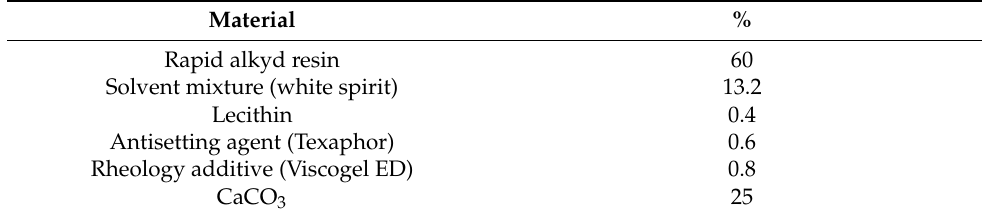
Table 1. Formulation for the alkyd-based wood